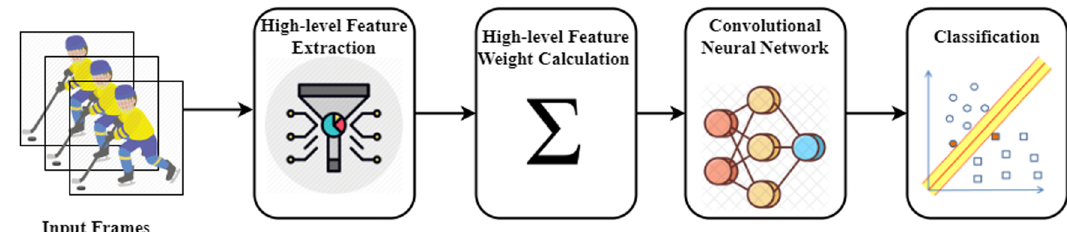
Figure 2: Proposed CNN - RTIPF